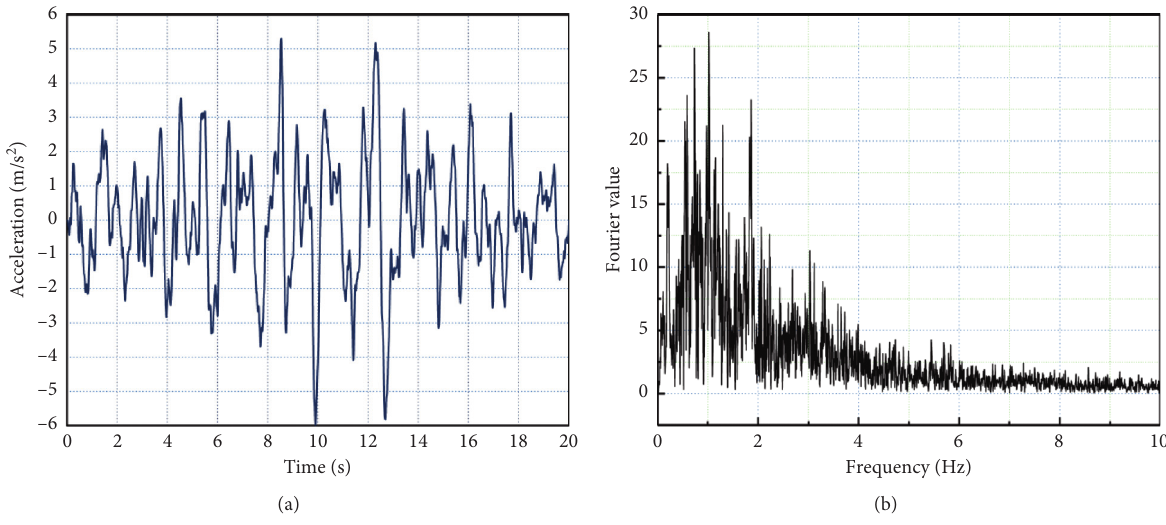
Figure 6: (a) Wenchuan seismic wave. (b) Fourier transform